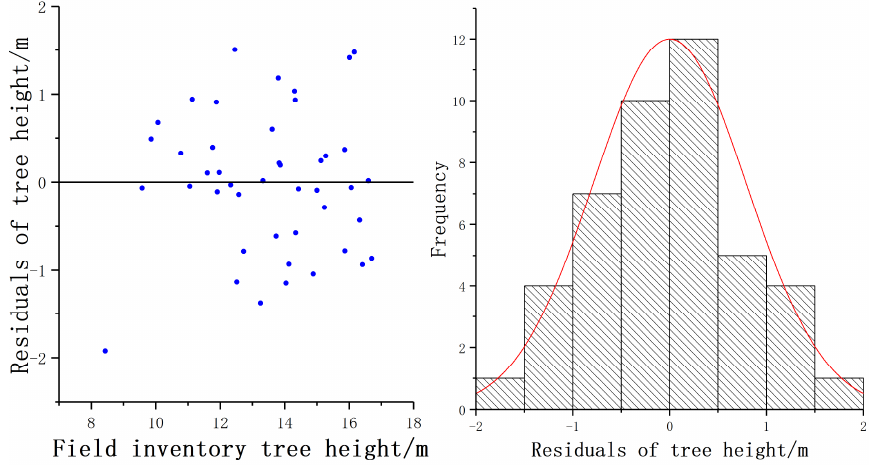
Figure 13. The residuals distribution of tree height.